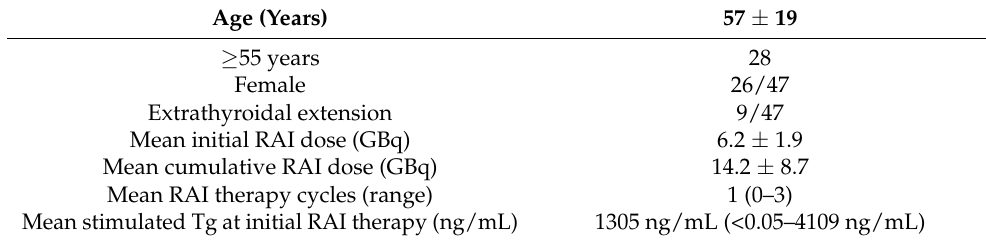
Table 1. Patient characteristics.